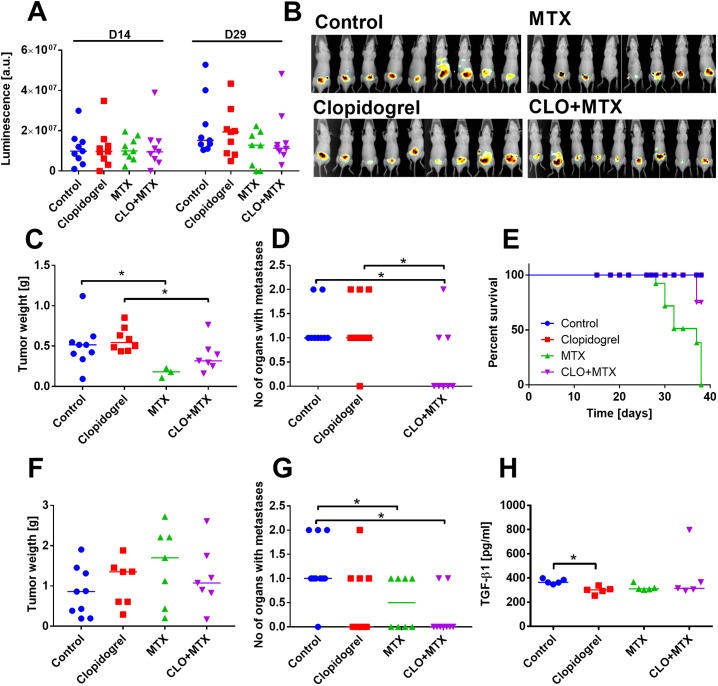
Clopidogrel protects against the toxicity of MTX in mice bearing human PC-3M-luc2 prostate tumors.(A) Luminescence of prostatic tumors on day 14 (a day prior to the treatment initiation) and 29. (B) Photographs of mice on day 29 of experiment. (C) Tumor weight of tumors harvested on day 37. (D) Number of organs with diagnosed metastases. (E) Survival curves. (A)–(E) Data from mice treated with 3 mg/kg/dose of MTX. All mice were euthanized on day 37; the number of animals euthanized before: 10. N = 9 mice per group. (F) Tumor weight of tumors harvested on day 47. (G) Number of organs with diagnosed metastases. (H) Transforming growth factor β1 (TGF-β1) plasma level. (F)–(H) Data from mice treated with 1 mg/kg/dose of MTX. All mice were euthanized on day 47. N = 7–9 mice per group. All graphs show values for individual animals with median line; the exception: (E) shows percent of survival on indicated days. Statistical analysis: Kruskal–Wallis test for multiple comparisons, *p<0.05. Survival analysis: Mantel–Cox test showed significant differences between survival curves (p<0.0001).